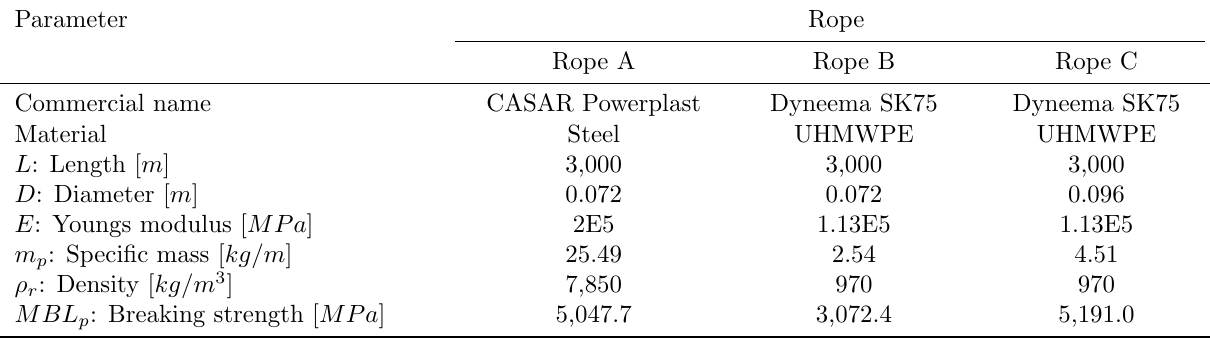
Table 1: Dimensions and material properties of ropes A, B and C